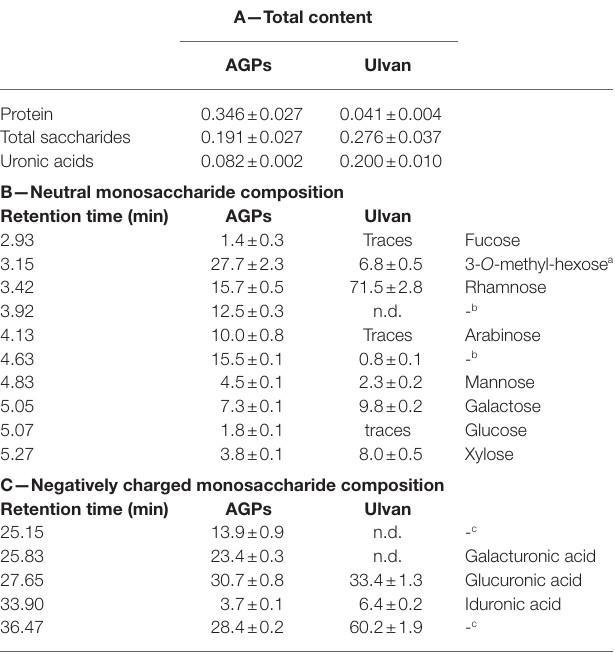
TABLE 1 | The characterisation of